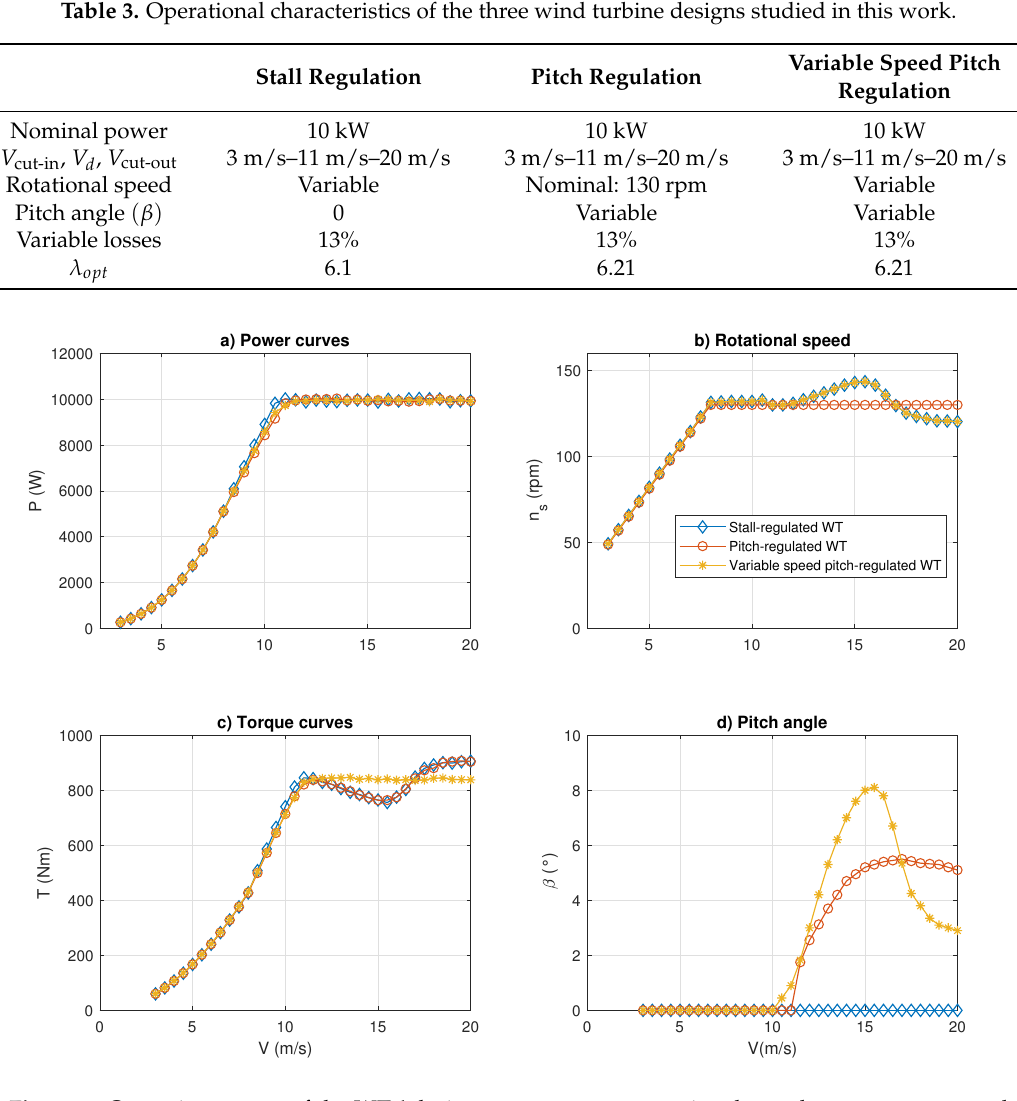
Figure 5. Operation curves of the WTs’ designs: power curve, rotational speed, torque curves, and pitch